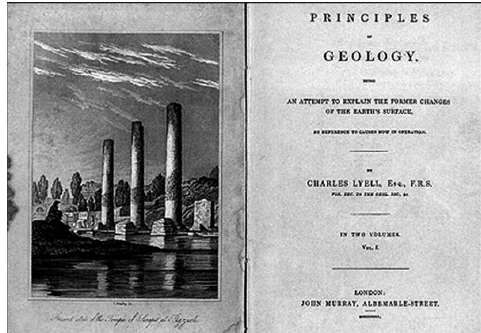
Fig. 3. Temple of Serapis, Pozzuoli (Neaples), on the cover of Lyell’s Principles of Geology,